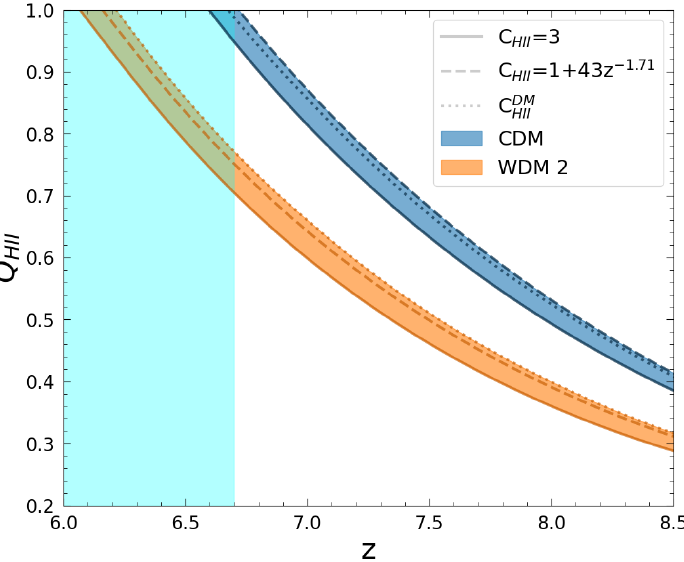
Figure 6. Evolution of the filling fraction with different clumping factor models, for two representa- tive cosmologies: the continuous line refers to fixed C HII = 3, while the dotted and the dashed lines indicate respectively models dependent on redshift and cosmology (Trombetti et al. (2014) [56]), and on redshift